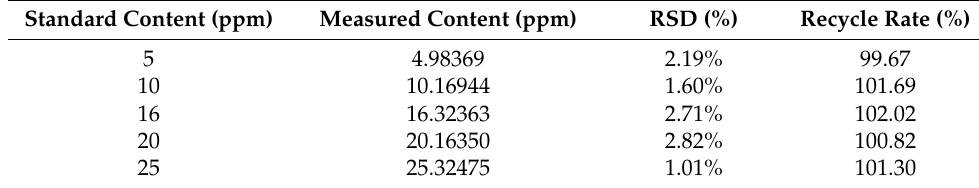
Table 1. RSD and Recycle rate.